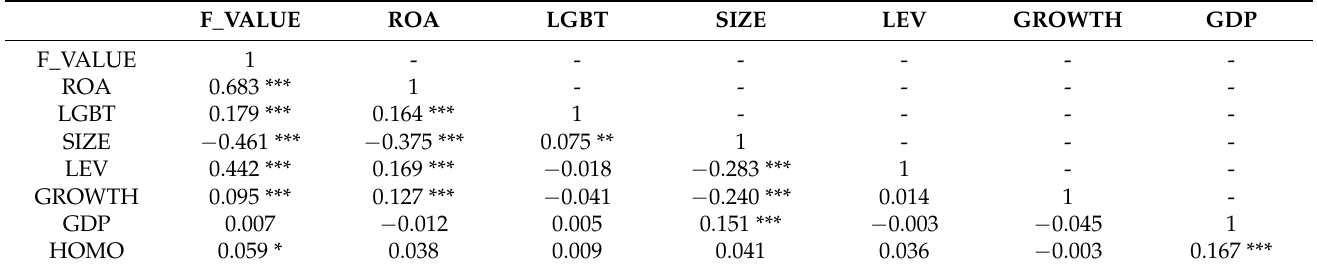
Table 4. Correlation